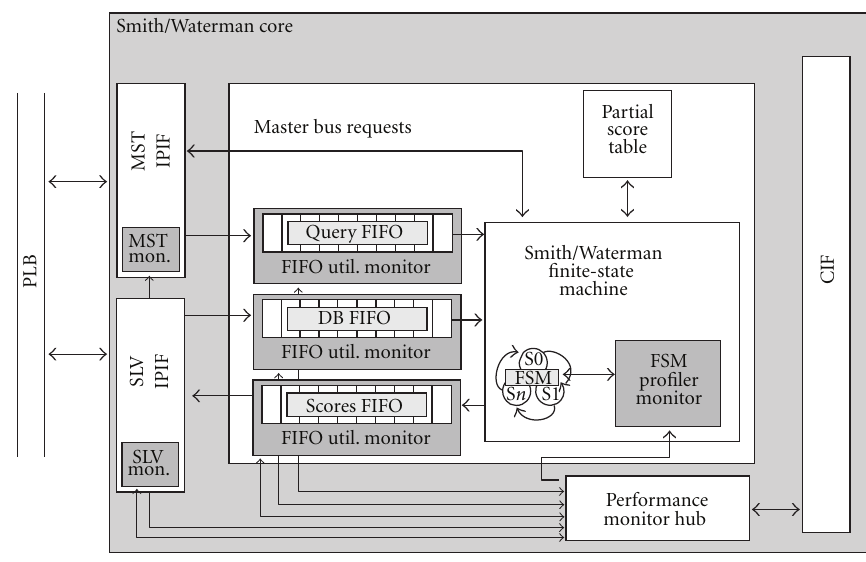
Figure 10: Smith/Waterman core’s performance